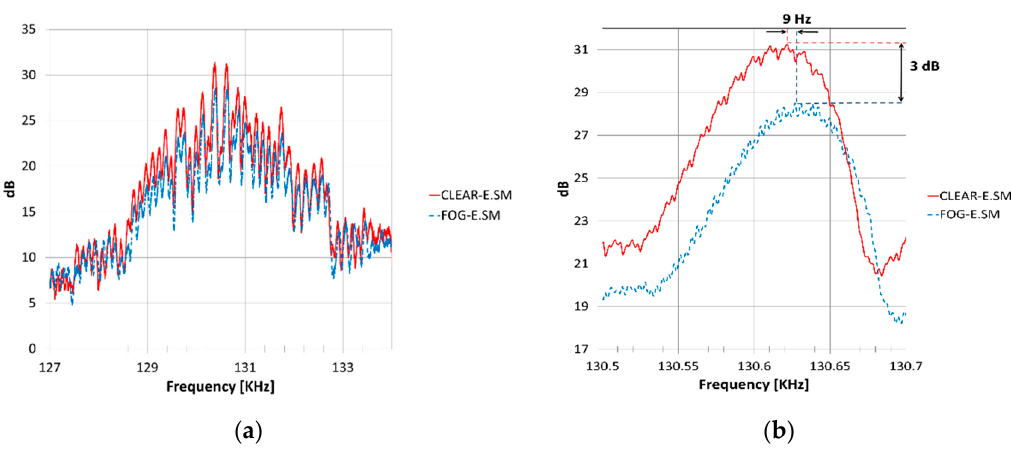
Figure 7. ( a ) The detected intermediate frequency (IF) signal spectrum when the target is at a physical distance of 18.8 m in both cases with and without fog; ( b ) after filtering and smoothing. Table 3. Simulation and experimental results for frequency of 320 GHz at distance d = 18.8 m.